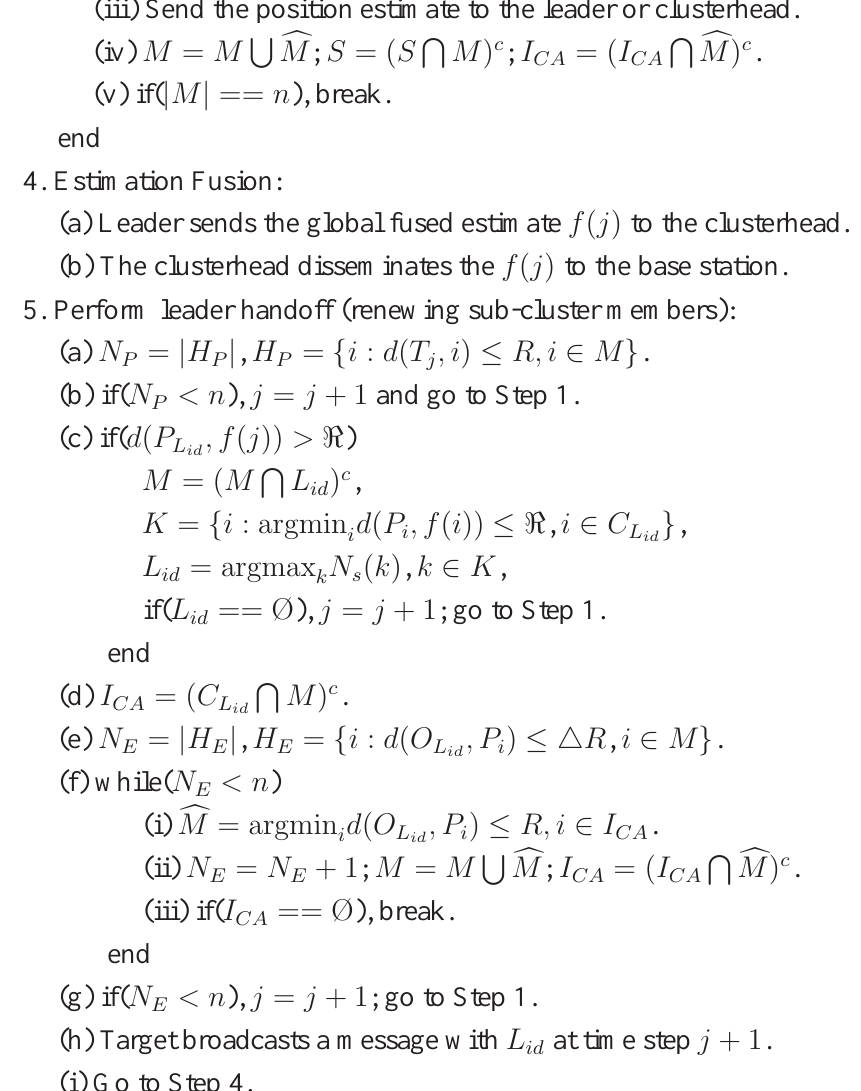
Table 2. Procedures of the TCAT model for target